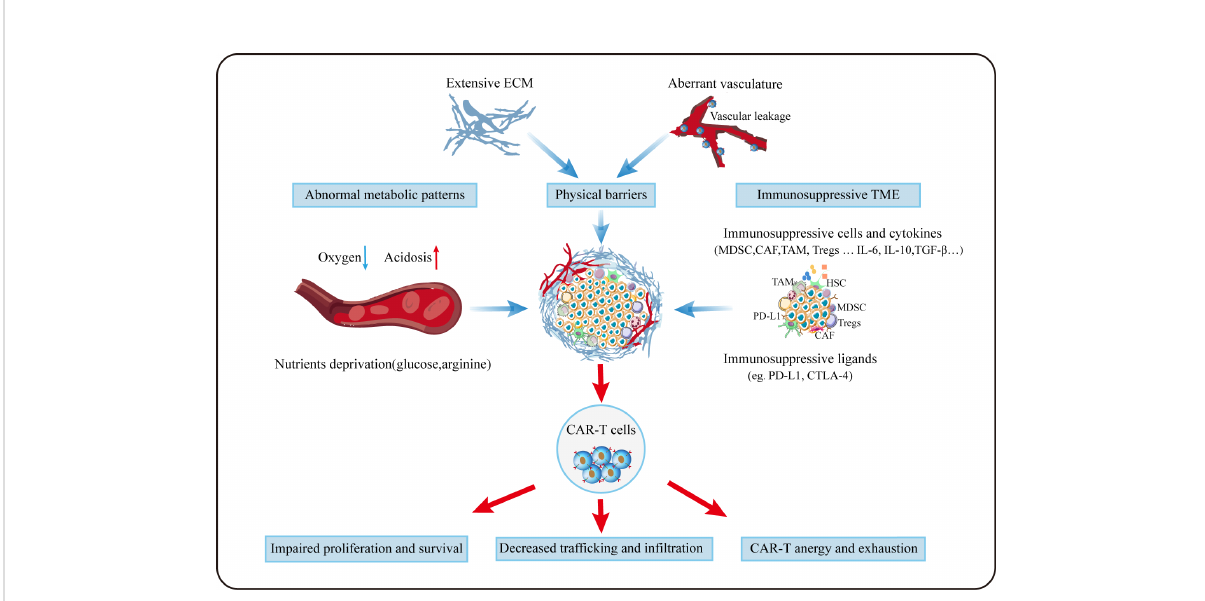
FIGURE 3 Challenges for CAR-T cells in TME. Aberrant vasculature and extensive ECM forms the special physical barriers making it dif fi cult for CAR-T to ef fi ciently traf fi c and in fi ltrate towards tumor tissues. Due to aberrant vasculature and the enhanced metabolism of tumor, CAR-T cells grow in a hypoxic, acidic and nutrition-deprivation milieu. Besides, immunosuppressive cellular and noncellular components can deactivate T cells via diverse